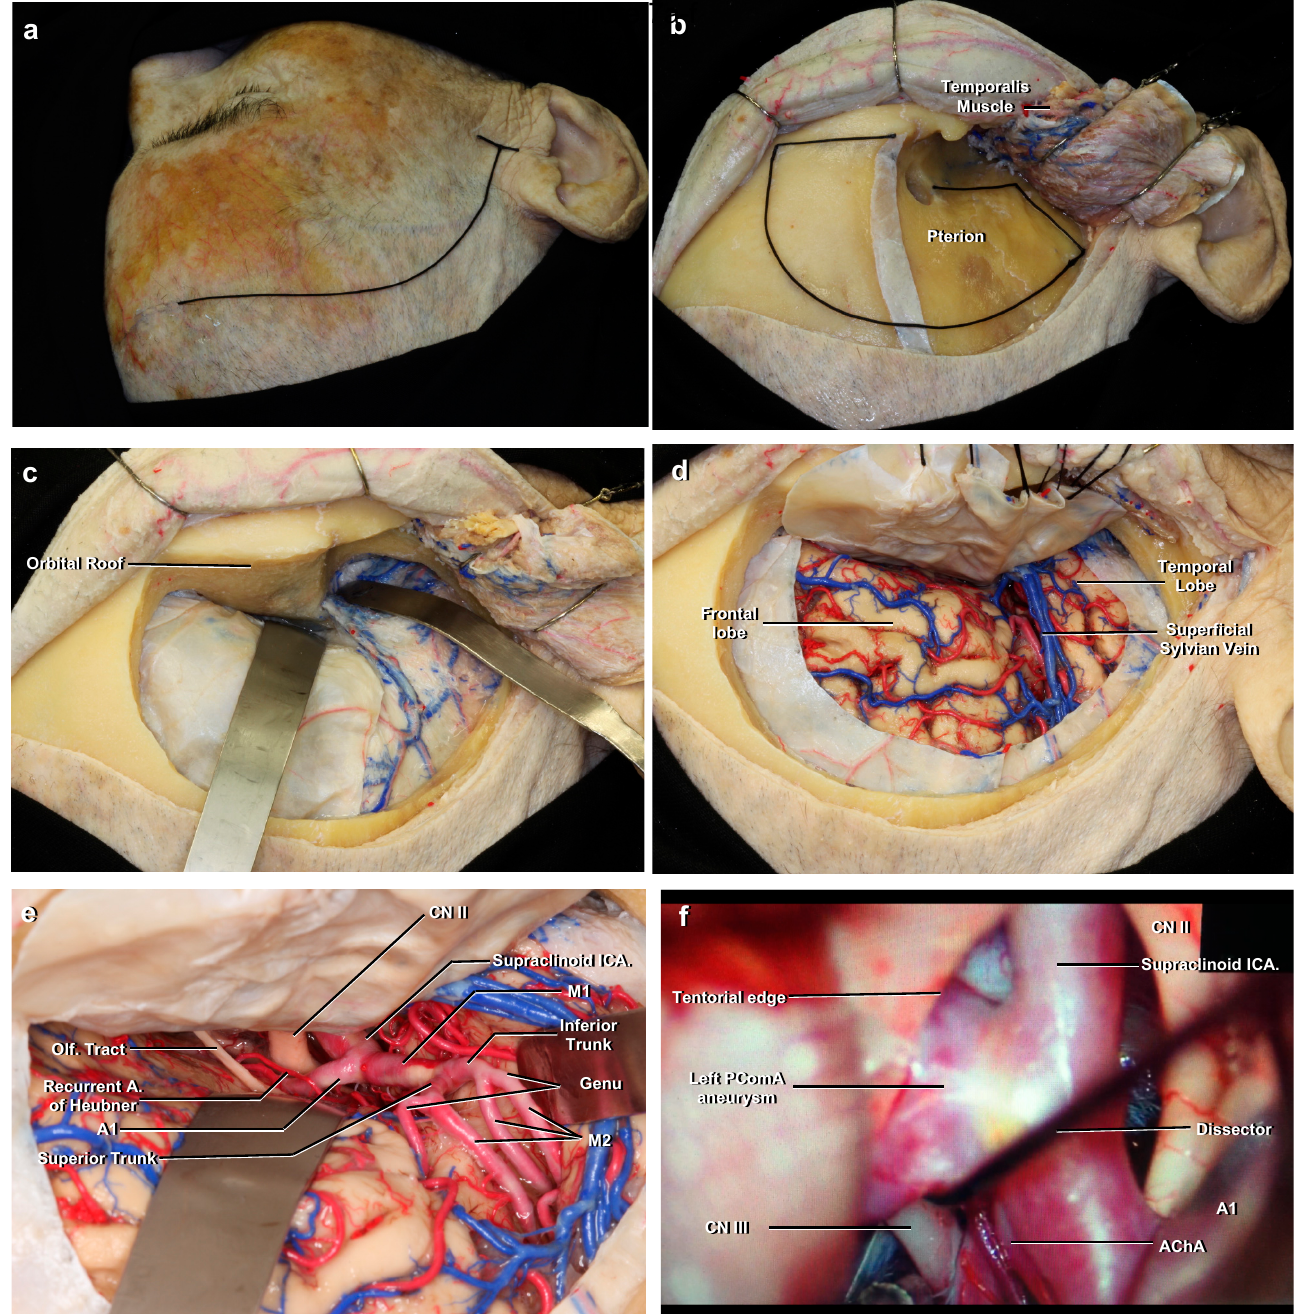
Figure 7. ( a ) The positioning and the skin incision for the classic pterional approach. Right side. ( b ) After the scalp flap is made to protect the temporal branches of the facial nerve, the temporalis muscle is reflected posteroinferiorly to expose the pterion. A frontotemporosphenoidal craniotomy is planned. ( c ) After the removal of the bone flap, the orbital roof and lesser wing of the sphenoid bone are drilled. ( d ) After opening the dura, the frontal and temporal lobes and superficial sylvian veins are exposed. ( e ) After the sylvian fissure has been widely opened, the main neurovascular structures are seen. ( f ) Left pterional approach during treatment of the left PComA aneurysm previously shown in Figure 5D. A dissector is gently pressuring upward to demonstrate the proximity of the distal neck to the origin of the AChA.